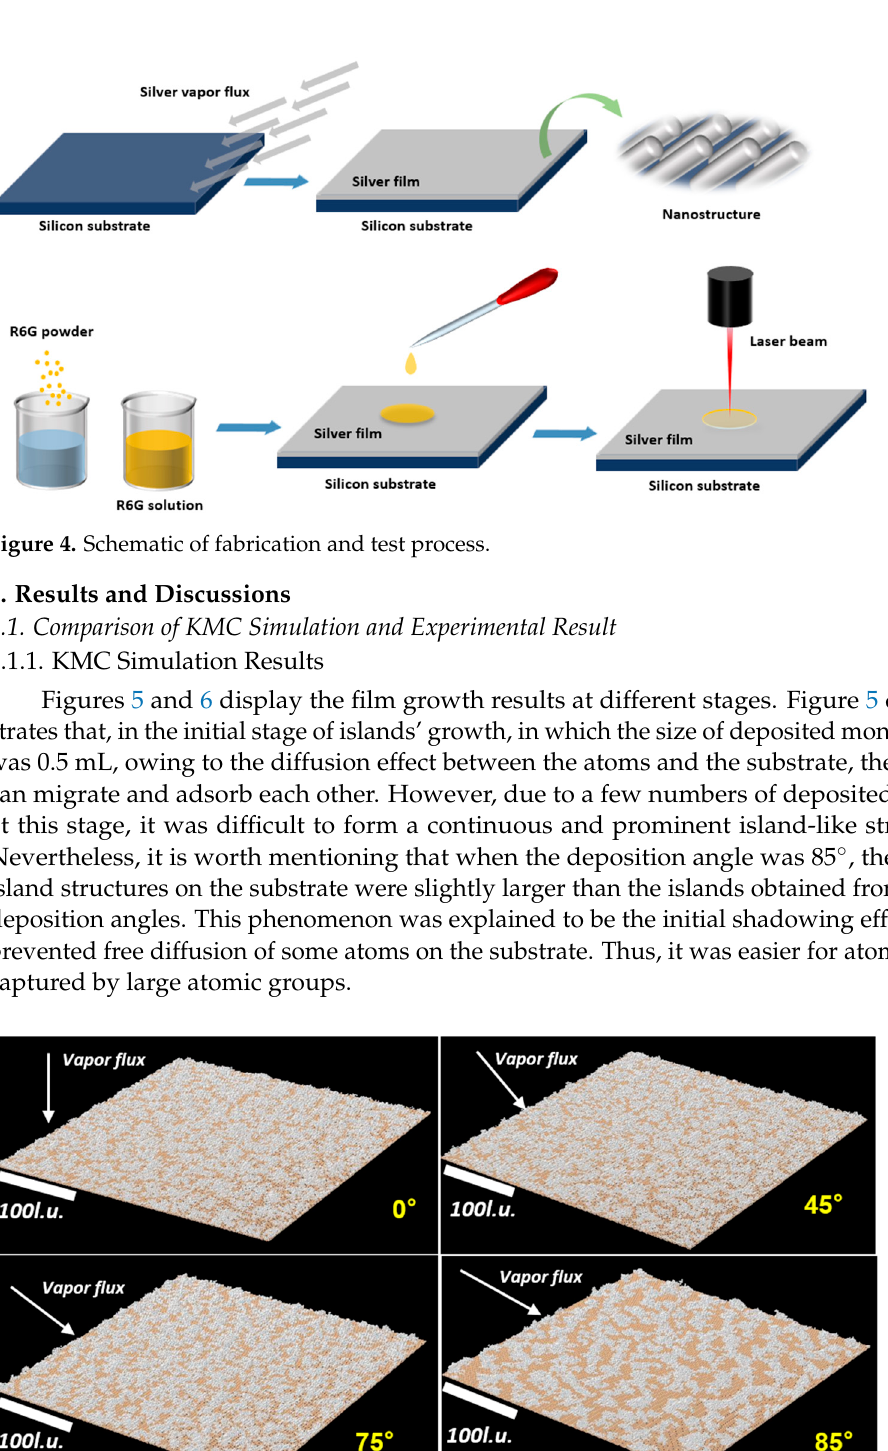
Figure 6. Film growth simulation results at the initial nanostructure growth stage (2.5 mL) under different deposition angles. Figure 6 displays the film growth results under various deposition angles at the initial nanostructures’ growth stage, in which the size of deposited monolayers was 2.5 mL. In this stage, more atoms covered the substrate, forming a layered film or initial nanostruc- ture. Figure 6 indicates that when depositing at a low angle, the deposited atoms can dif- fuse and combine readily with each other on the substrate due to the relatively weak shad- owing effect, resulting in a continuous layered film without any nanostructure. However, the film obtained at a high deposition angle showed prominent initial nanocolumn struc- tures. The reason is the shadowing effect is drastically enhanced by increased deposition angle, inducing many atoms’ failing to diffuse and migrate into the shadowing area. As the deposition process continued, the atoms continuously adsorbed and deposited on the atomic group, resulting in oriented growing along a specific direction and forming the initial nanostructures. Figure 7 gives the top view of the initial nanostructure of Ag thin film. It can be observed clearly that the initial nanostructure of Ag thin film became more significant due to a more substantial shadowing effect, which was related to increased deposition angles.